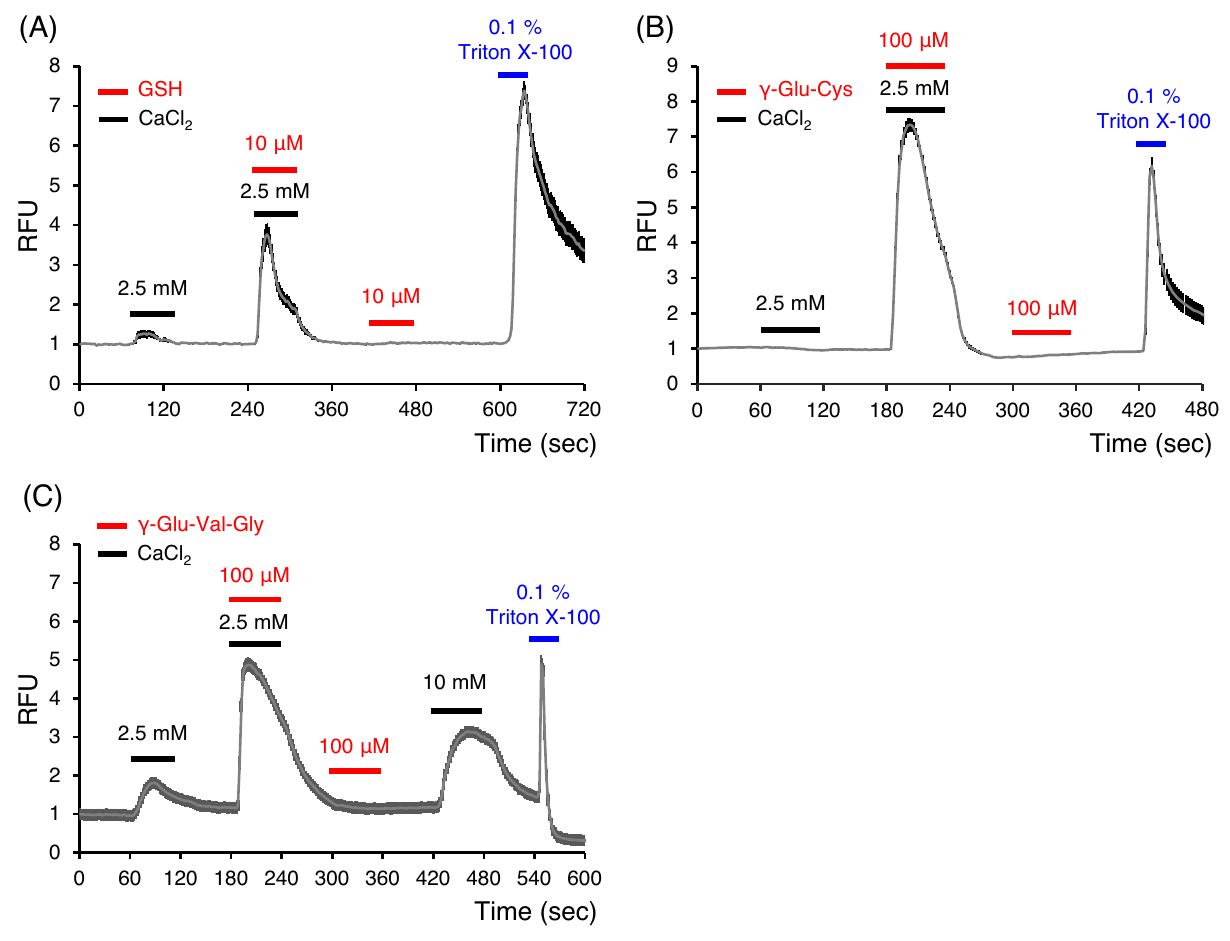
Figure 5. Glutathione (GSH), γ-Glu-Cys, and γ-Glu-Val-Gly enhanced cCaSR activities with 2.5 mM CaCl 2 . ( A ) Ten μM GSH enhanced cCaSR activity with 2.5 mM CaCl 2 . ( B ) One-hundred μM γ-Glu-Cys enhanced cCaSR activity with 2.5 mM CaCl 2 . ( C ) One-hundred μM γ-Glu-Val-Gly enhanced cCaSR activity with 2.5 mM CaCl 2 . RFU: relative fluorescence units, the index of cytosolic Ca 2+ concentration. Data are means ± SE (n = 70–100